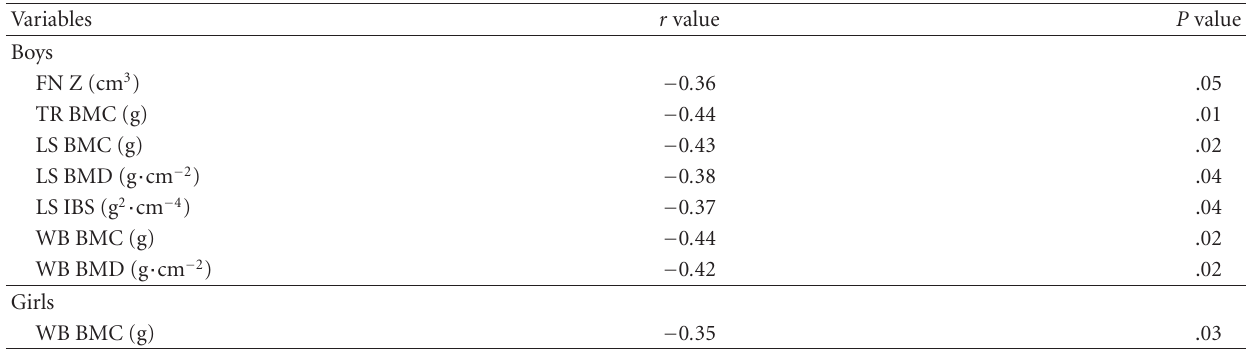
Table 3: Significant relationships between duration of television viewing and bone parameters for adolescent boys and girls ( n = 99). Variables r value P